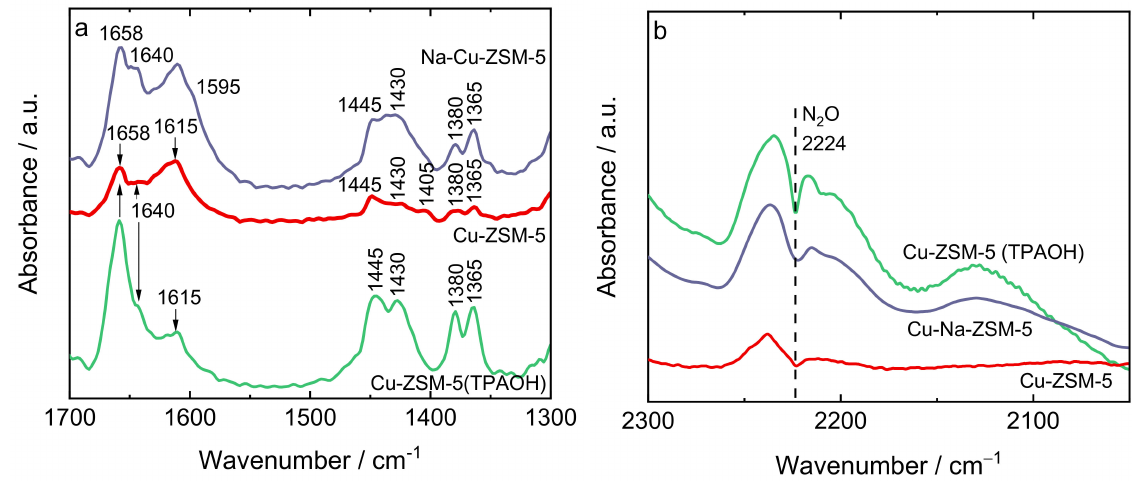
Figure 14. FT-IR difference spectra collected at 150 ◦ C after the adsorption NO, O 2 and NH 3 in the stoichiometric amounts ( c (NO)/ c (O 2 )/ c (NH 3 ) = 4:1:4) on the Cu-exchanged ZSM-5 in the range of: ( a ) 1700–1300 cm − 1 and ( b ) 2300–2050 cm − 1